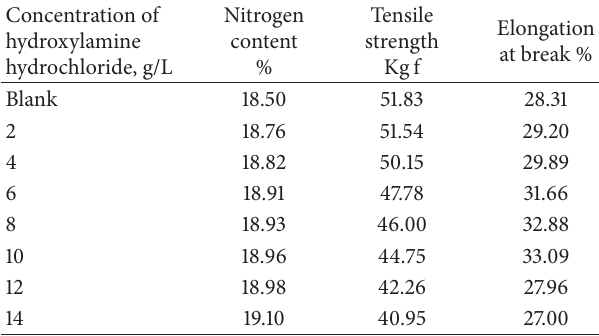
Table 1: Nitrogen content, tensile strength, and elongation at break of blank and modified acrylic